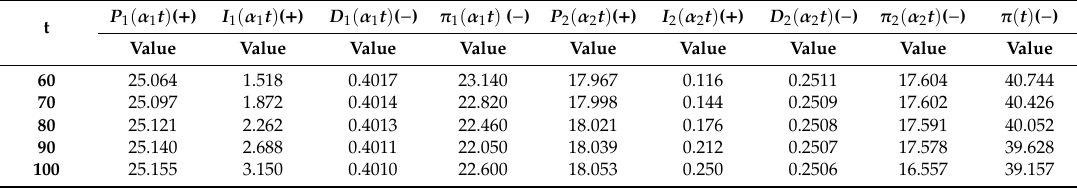
Table 5. Sensitivity analysis of α 1 : α 2 = 60%:40%. Unit: million